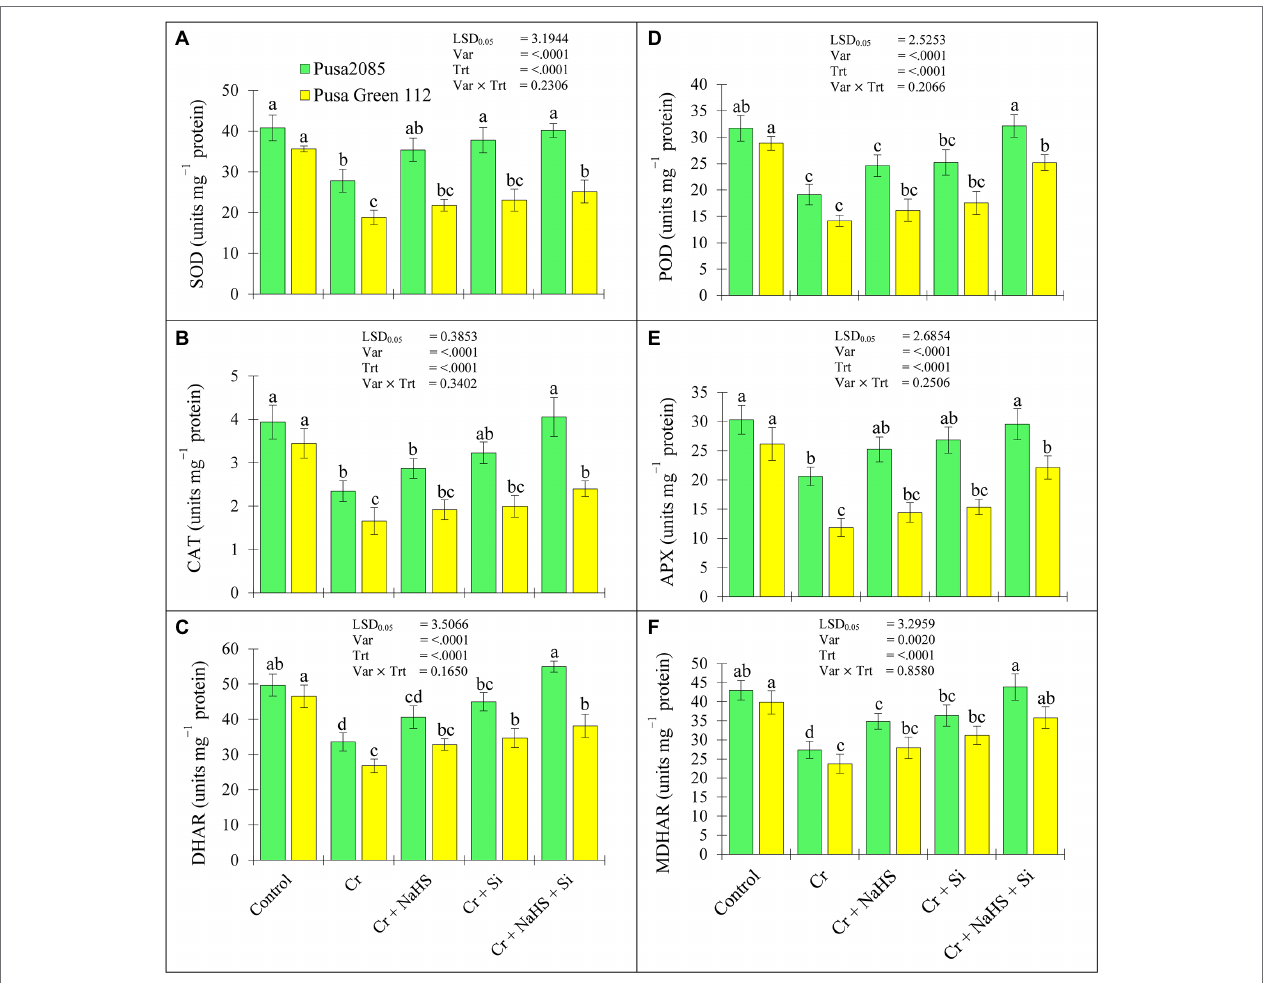
FIGURE 4 | Effect of NaHS, Si, and NaHS + Si treatments enzymatic activities of (A) SOD-superoxide dismutase, (B) CAT-catalase, (C) DHAR-dehydroascorbate reductase, (D) POD-peroxidase, (E) APX-ascorbate peroxidase, (F) MDHAR-monodehydroascorbate reductase in leaves of both chickpea plants grown during Cr VI stress. Data are presented as mean ± SE ( n = 5) and different bar letters are indicated statistically differences ( p < 0.05) as tested by the least significant difference